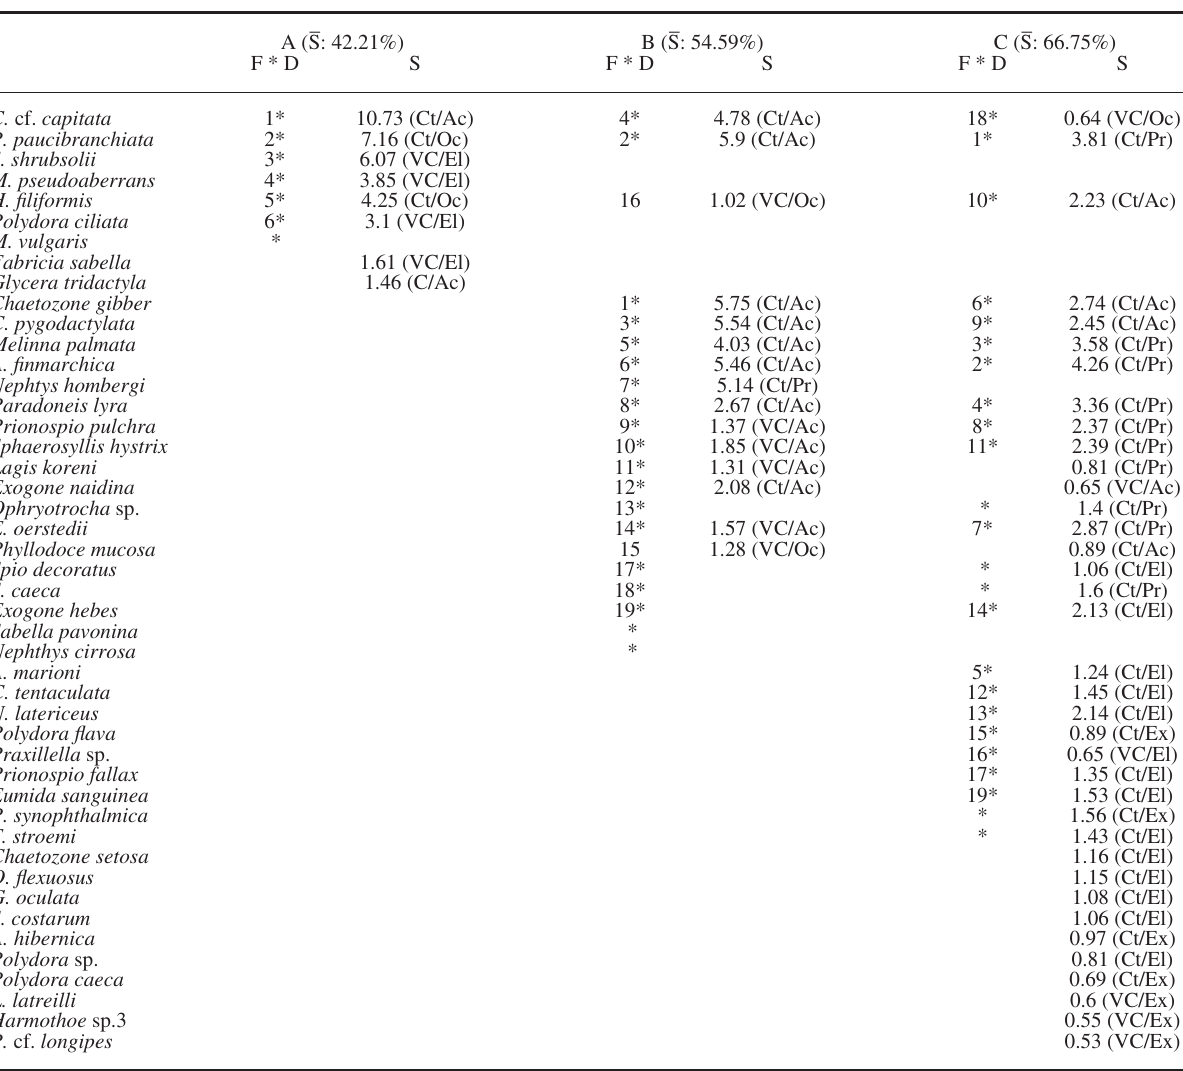
Table 4. – summary of characteristics for each association. – ii. species with highest FxD values (Frequency*average Dominance in de- s– , average similarity for the group; species creasing order: 1, 2, 3...); *, dominant species for each group up to 90% accumulated dominance; that contribute most to similarity (s) for each group; Constancy (Ct, constant; vC, very common) and Fidelity (Ex, Exclusive; El, Elective; Pr, Preferential; ac, accesory, oc, ocasional). (s– a :